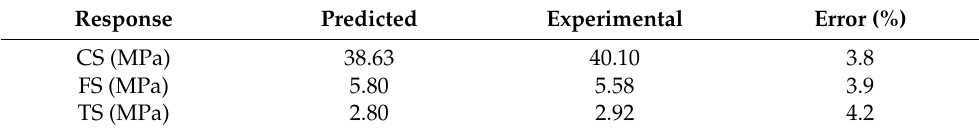
Table 7. Experimental